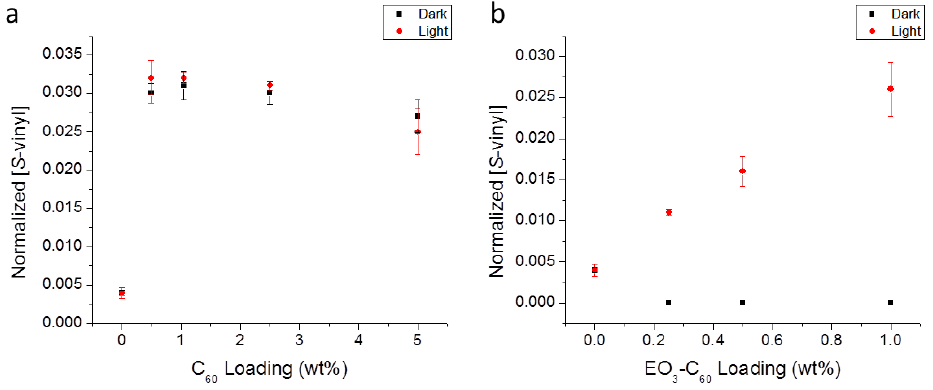
Figure 8. Hypothesized Lewis acid catalyzed sulfide